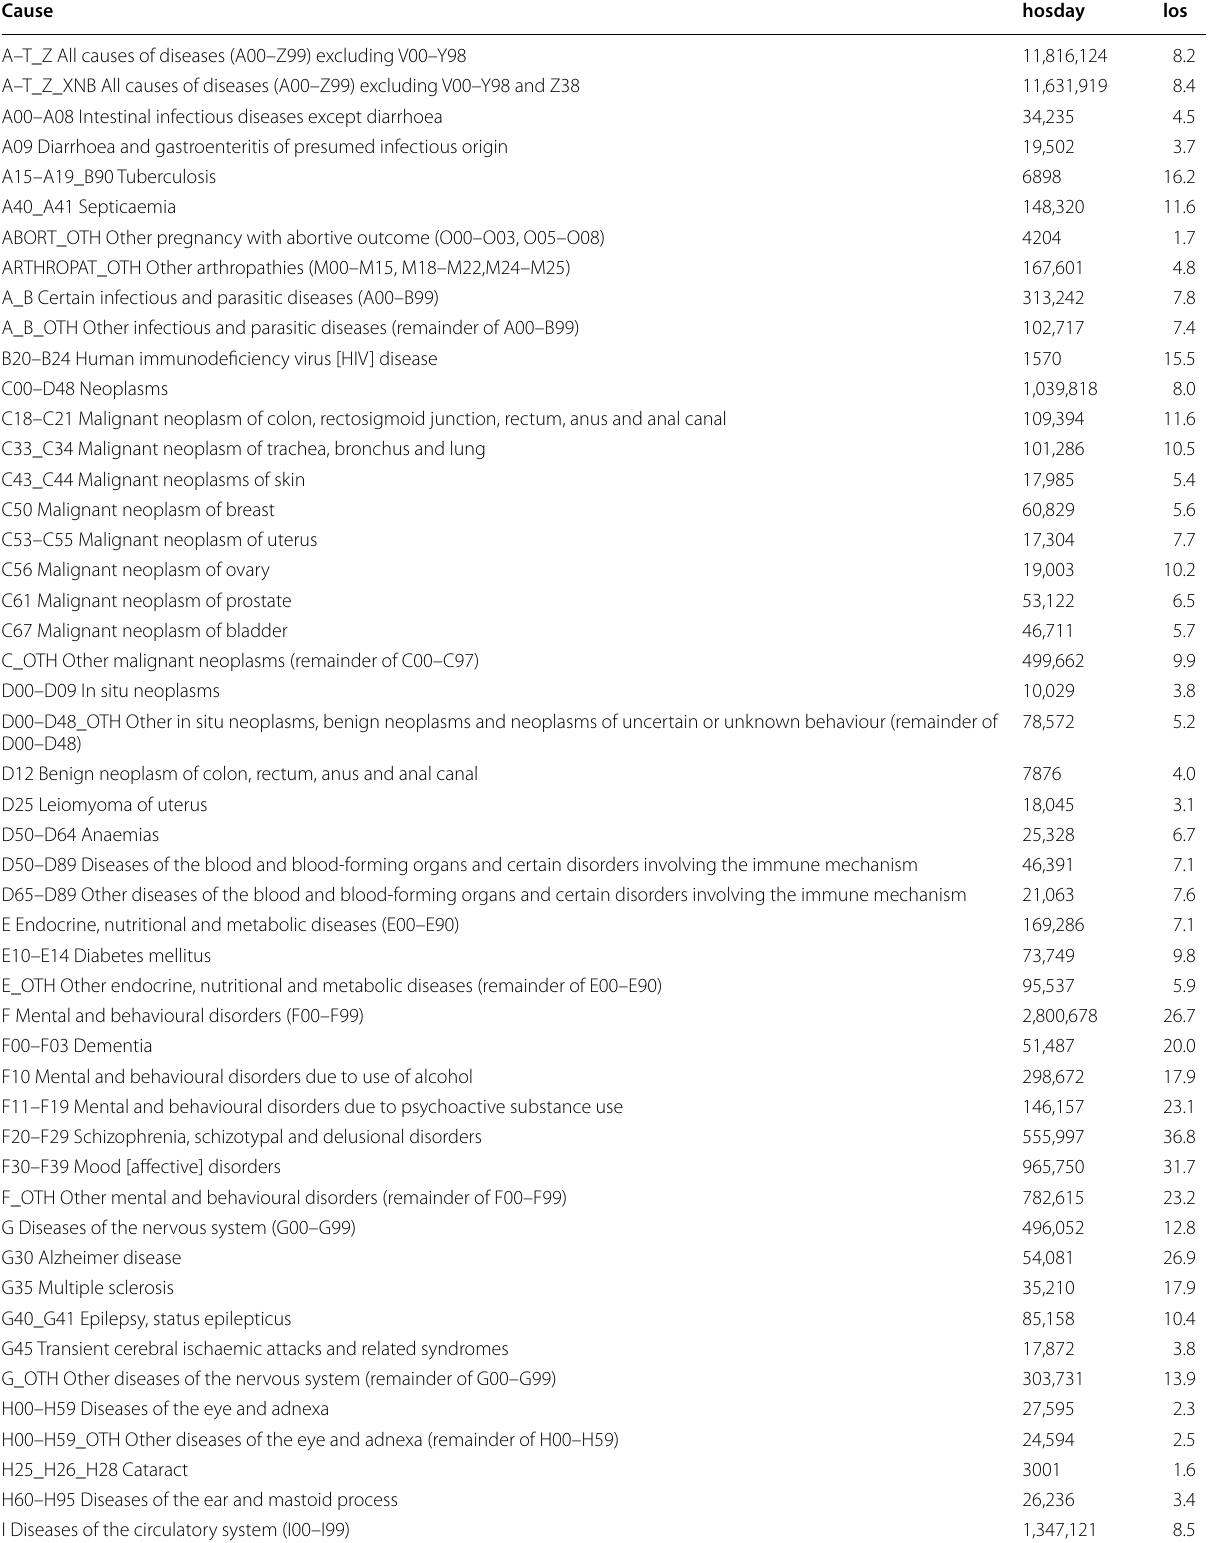
Table 6 Hospital days and average length of stay, by cause, in